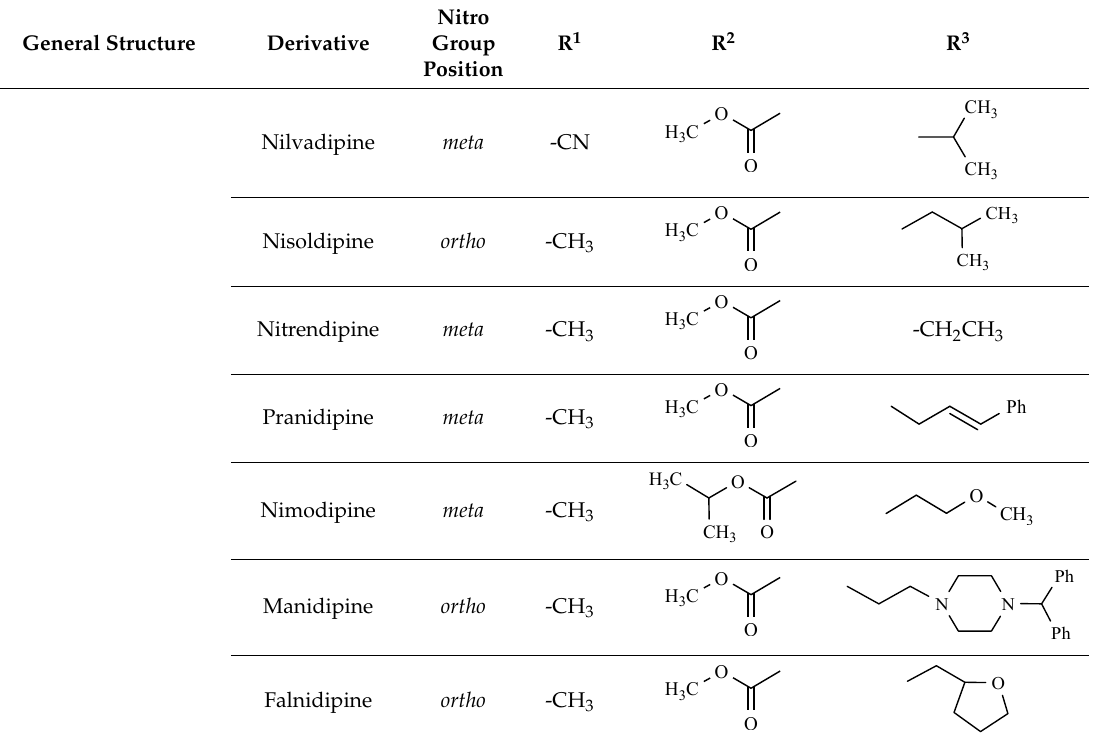
Table 1. Nifedipine derivatives.